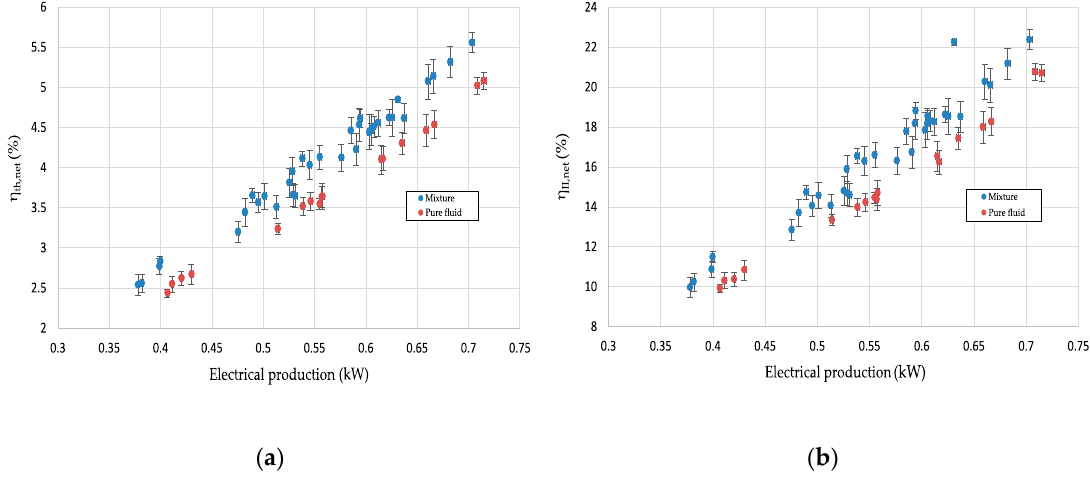
Figure 6. The ORC performance according to electrical production in the pure fluid and the mixture. 358